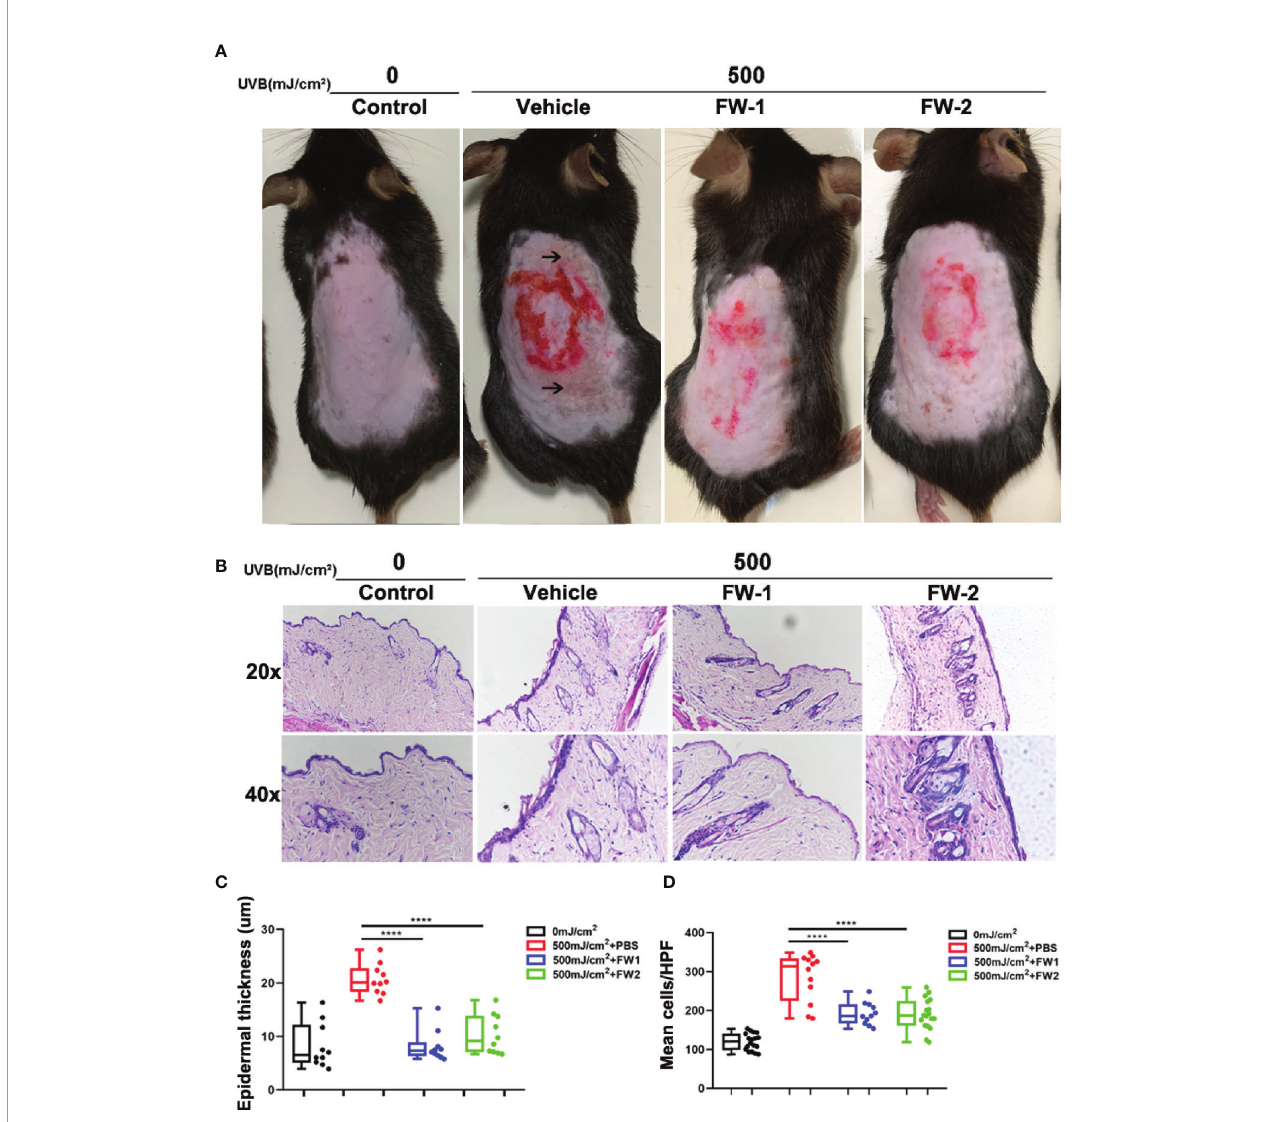
FIGURE 3 | FW-1 and -2 have protective effects in UV-induced skin in fl ammation. (A) Representative photographs of mice skin with or without FW-1 and -2 treatment (5 mg/kg) after 48 hr post UV exposure (500 mJ/cm 2 UVB). Arrows indicate areas with obvious sunburn reactions such as blisters and skin peeling. Red circle indicate areas where we intradermal injected with samples and section for HE staining. (B) Histology of the mice skin with or without FW-1 and -2 treatment after 48 hr of UV irradiation (500 mJ/cm 2 UVB). Skin sections were stained with H&E. Box and whisker plot indicating skin thickness (C) and immune cell in fi ltration (D) measured after 48 hr post UV irradiation (500 mJ/cm 2 UVB) using ImageJ software (n=10). Scale bars, 50 m m. ****P <